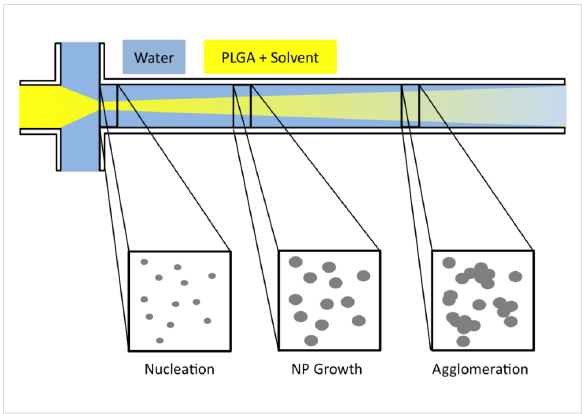
Figure 8: Illustration of nucleation and growth mechanism of nanopre- cipitation along the focus mixing channel in a microfluidic system.